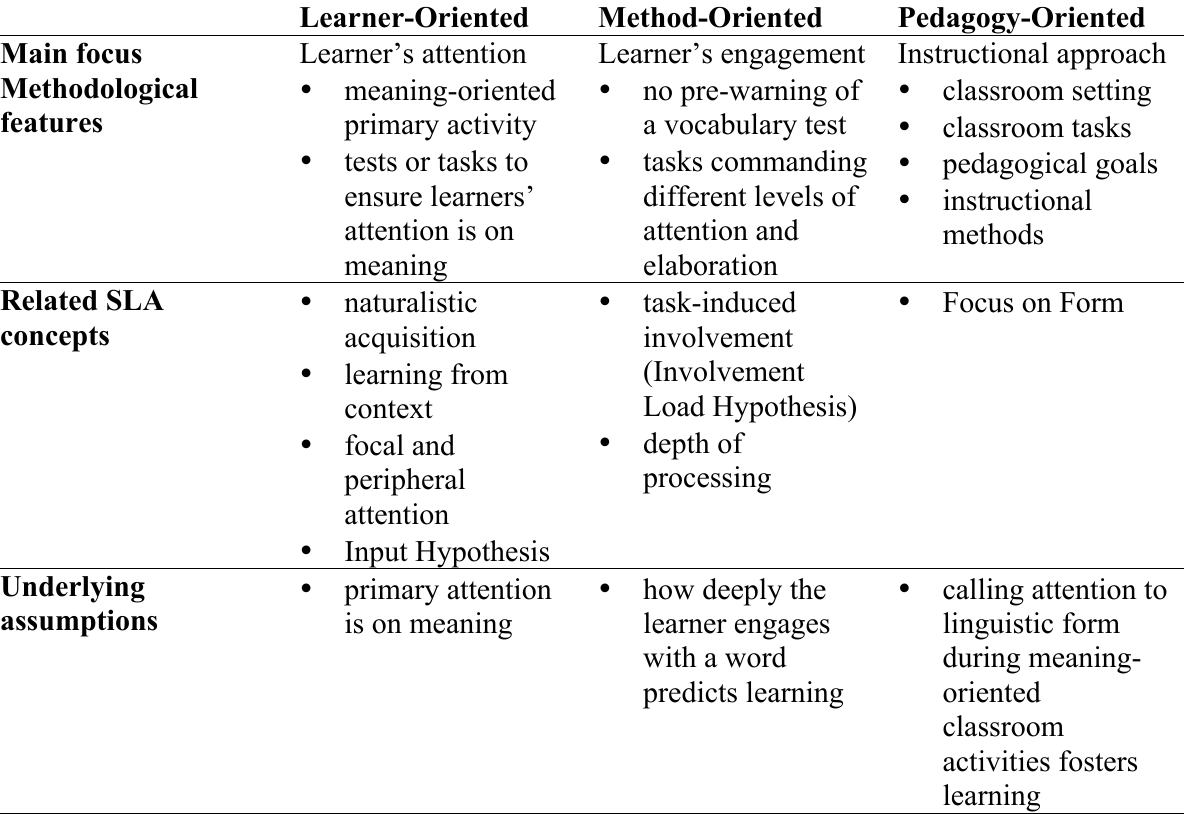
Three definitions of “incidental learning” and their key differentiating